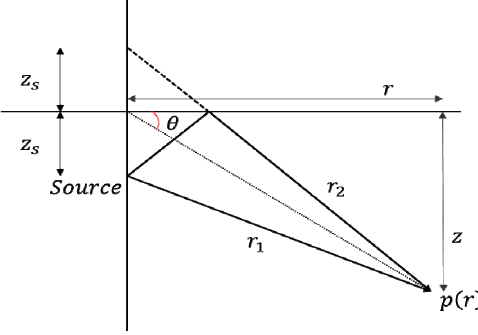
Figure 11. Interference schematic diagram of two sound rays.